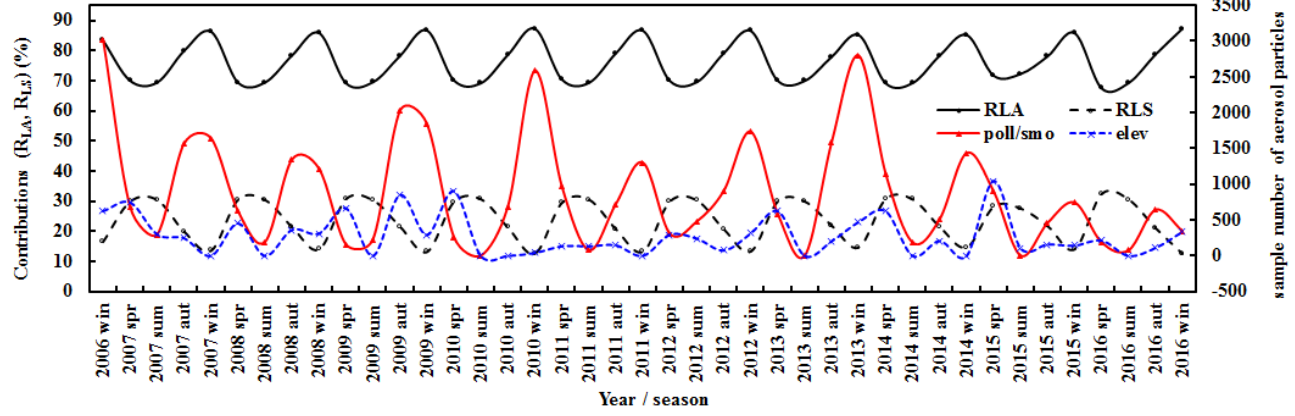
Figure 16. Contributions (R LA and R LS ) of seasonal absorbing and scattering losses to the seasonal total loss and seasonal averages of sample number of polluted continental/smoke and elevated smoke aerosols (poll/smo, elev) at the Qomolangma